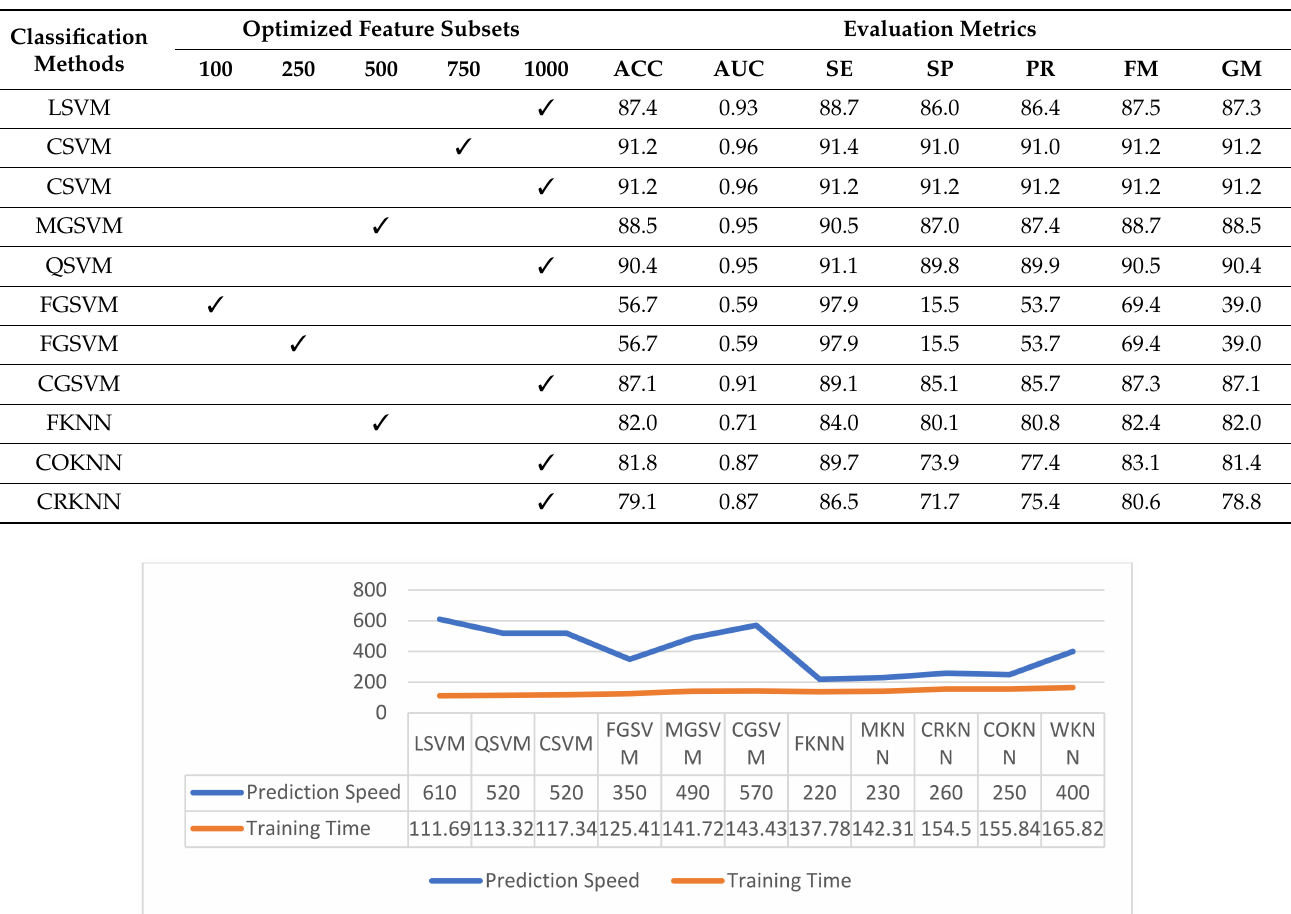
Table 14. Mixed view-based experimental results on PKU-Reid dataset.